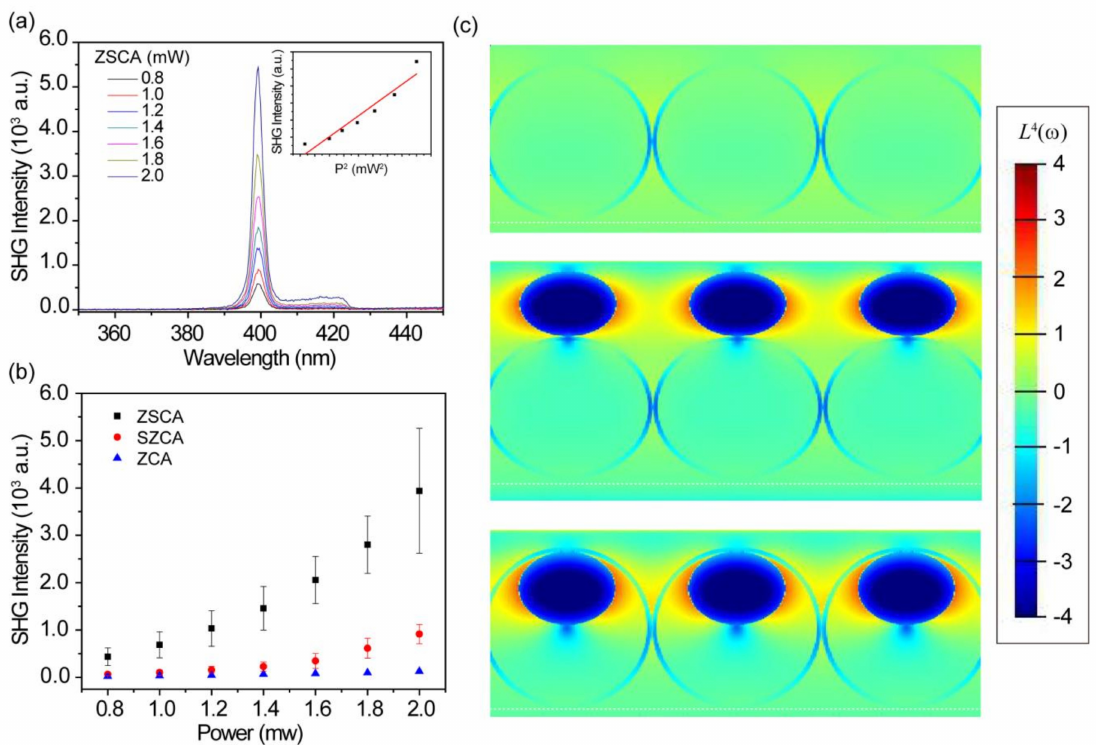
Figure 4. ( a ) Power-dependent plasmon-enhanced second-harmonic generation (PESHG): the emission intensity at second-harmonic (SH) wavelength increases quadratically with increased pumping power ranging from 0.8 mW to 2.0 mW. Inset: the measured PESHG intensity increases linearly with the square of pumping power ( P 2 ). ( b ) The comparison of power-dependent PESHG performances for ZSCA (black square dots), SZCA (red circle dots), and ZCA (blue triangle dots), respectively. Note that: the measured SHG intensity is a function of the excitation (average) power, which fits to a square dependence for all three samples. Error bars denote the deviation of the average SH signal intensity through multiple acquisitions from different spatial positions of the same sample. ( c ) Simulated near-field distributions of ZCA ( up ), SZCA ( middle ), and ZSCA ( bottom ) with a given excitation wavelength at 800 nm. All data are